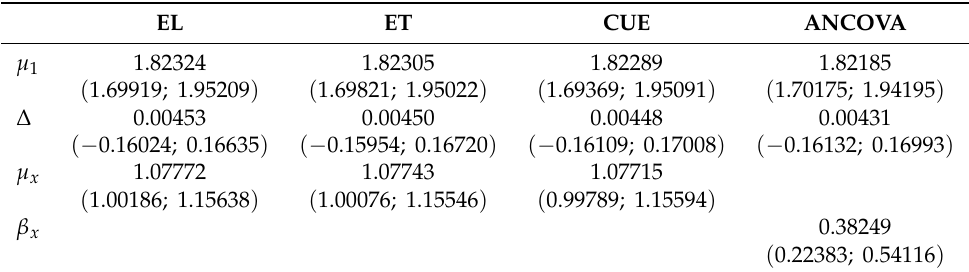
Table 9. Results of the statistical analysis of the data from the randomized study described in Lanphear et al. (2000) [4]. EL ET CUE ANCOVA µ 1